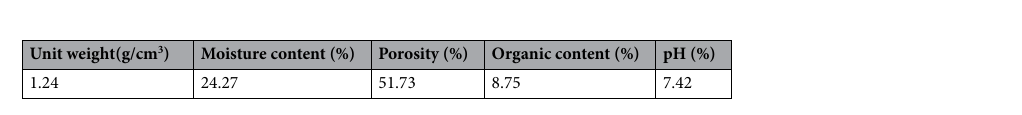
Table 1. Properties of the soil used in this